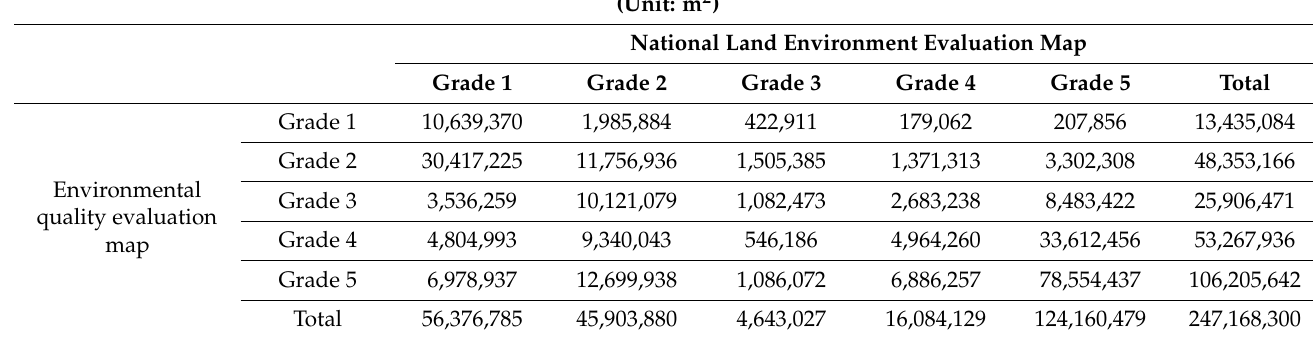
Table 4. Results of kappa analysis based on values from the national land environment evaluation map and environmental quality evaluation map. (Unit: m 2 ) National Land Environment Evaluation Map Grade 1 Grade 2 Grade 3 Grade 4 Grade 5